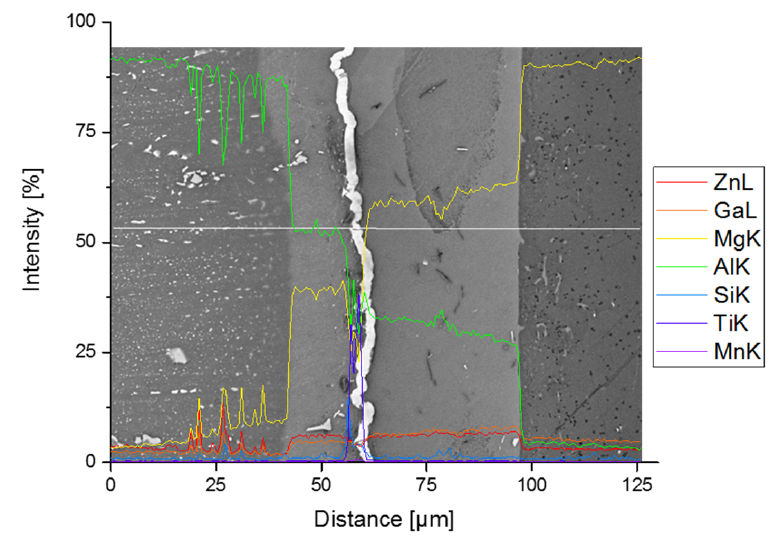
Figure 5. Elemental distribution across the interface of the Al-Mg joint of with titanium interlayer (Figure 4) measured by EDXS line scan.